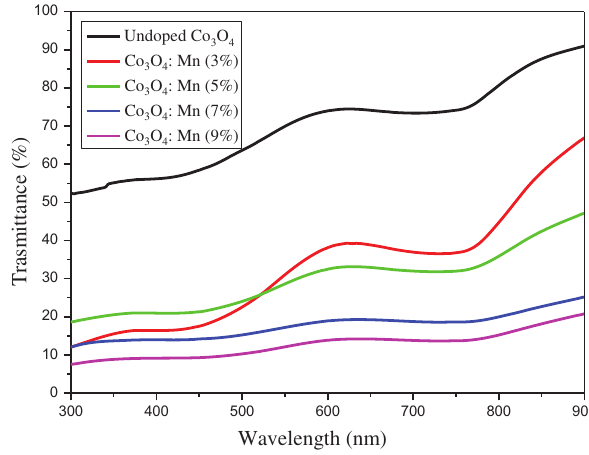
Figure 2: Transmittance spectra of Mn-doped Co 3 O 4